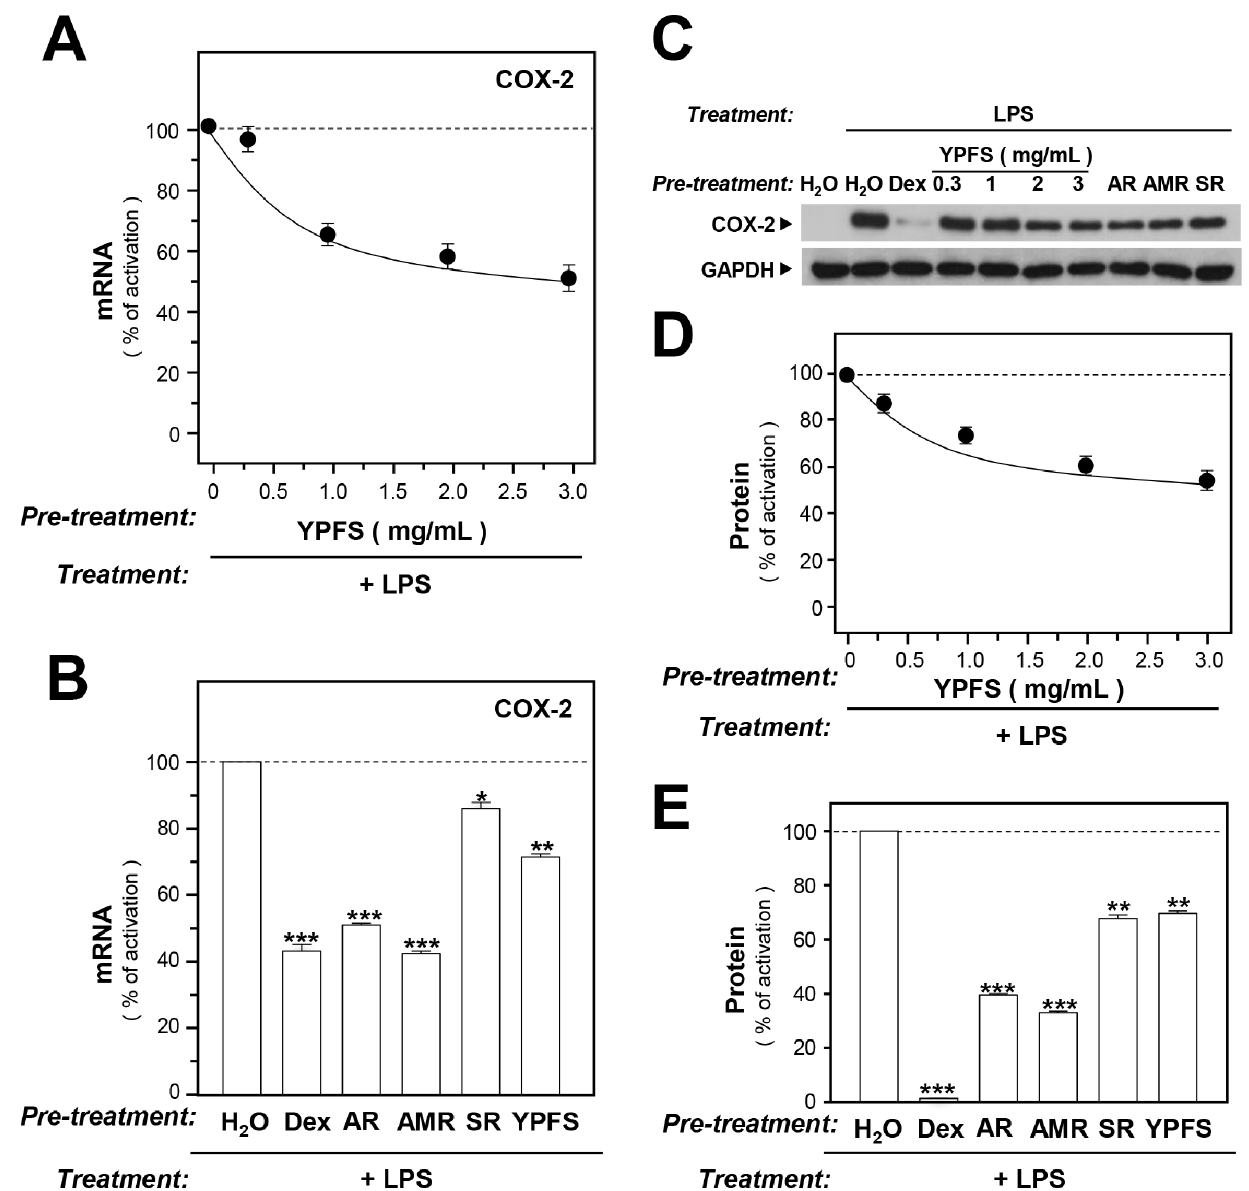
Figure 2. YPFS suppresses LPS-induced expression of COX-2 in cultured macrophages. Cultured macrophages were treated with herbal extracts and stimulated with LPS as described in Fig. 1 legend; 10 m M Dex was used as a positive control. The levels of COX-2 mRNA were determined using RT-PCR and normalized relative to the GAPDH signal. Lysed cells were prepared and equal amounts of proteins were subjected to western blotting performed using an antibody specific for COX-2. GAPDH was used as the internal control. ( A ): Suppression of COX-2 mRNA expression by YPFS in LPS-stimulated RAW264.7 cells. ( B ): Inhibition of COX-2 mRNA expression by herbal extracts of AR, AMR, and SR in LPS-stimulated RAW264.7 cells. ( C ): Representative western blots showing COX-2 staining. ( D ): Suppression of COX-2 protein expression by YPFS in LPS-stimulated RAW264.7 cells. ( E ): Inhibition of COX-2 protein expression by herbal extracts of AR, AMR, and SR in LPS-stimulated RAW264.7 cells. Results in (D) and (E) were calculated using the western blots shown in (C). Values are expressed as % LPS-induced activation; mean 6 SD are shown, n =4, each with triplicate samples. * p , 0.05; ** p , 0.01; *** p , 0.001.